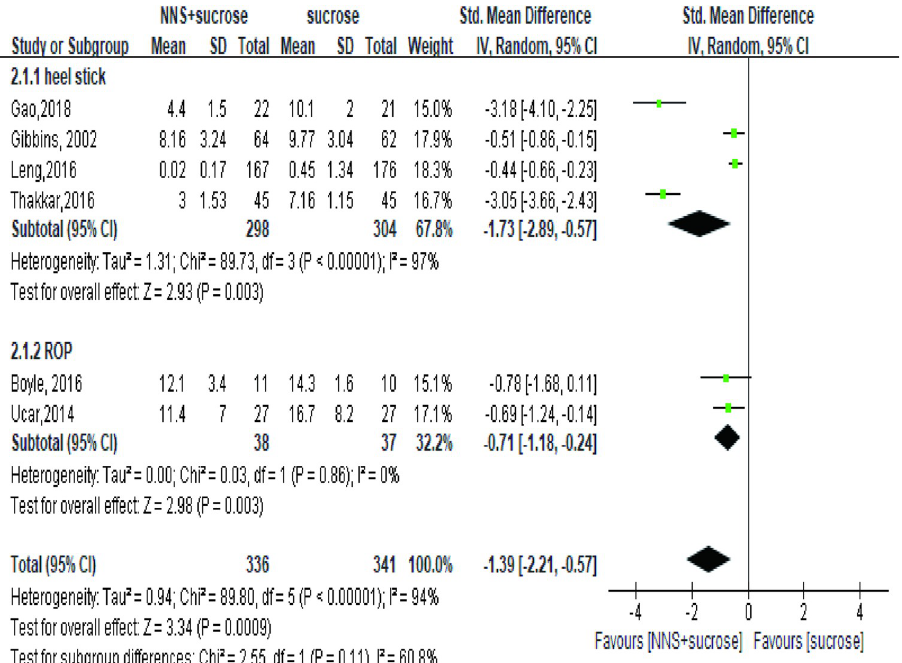
Fig 5. Forest plot of pain score comparing the combined intervention (NNS and sucrose) with applying sucrose alone during heel stick and ROP. NNS: nonnutritive sucking; ROP: retinopathy of prematurity. https://doi.org/10.1371/journal.pone.0268033.g005 population between the two studies (Fig 8). In Benoit’s study [47], full term infants underwent heel stick and were direct breastfed, whose pain was assessed by PIPP-R. In contrast, 66 pre- term infants underwent venipuncture in two sequences. During the controlling period, infants were given breast milk via a pacifier, whose pain was assessed by PIPP in Collados’s study [36].